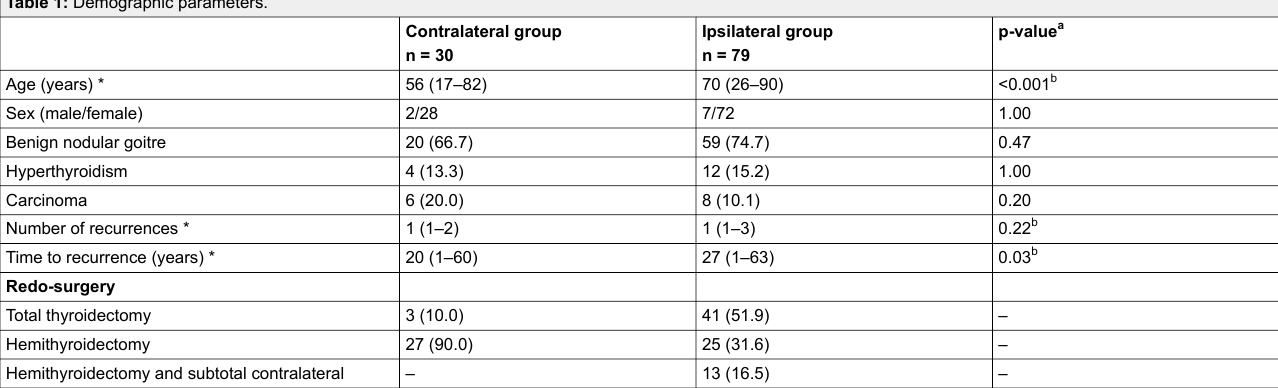
Table 1: Demographic parameters.